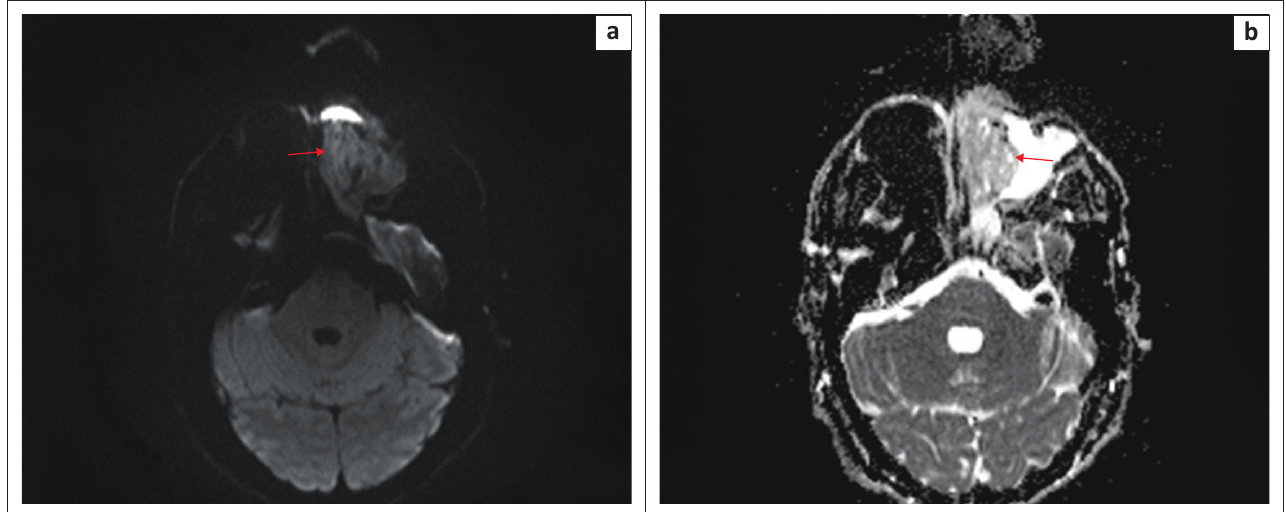
FIGURE 4: (a) Diffusion-weighted imaging B-1000/mm. The mass shows restricted diffusion (red arrow). There is an area of susceptibility artefact anteriorly and at the posterior skull base. (b) Axial ADC map MRI image shows a lobulated left nasal mass with restricted diffusion and small foci of T2 shine-through, ascribed to small foci of intratumoural cysts or necrosis (red